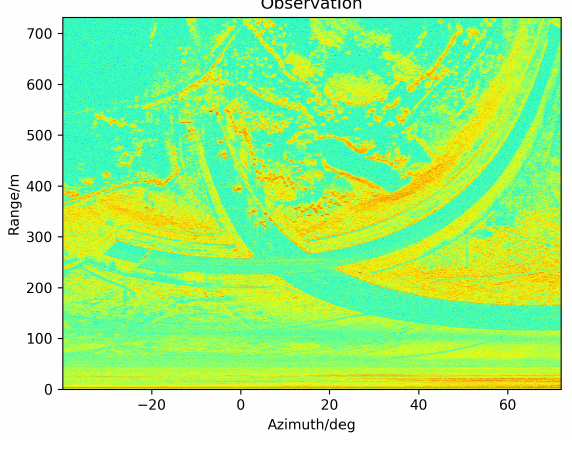
Figure 6. The experiment FOD millimeter-wave surveillance radar.